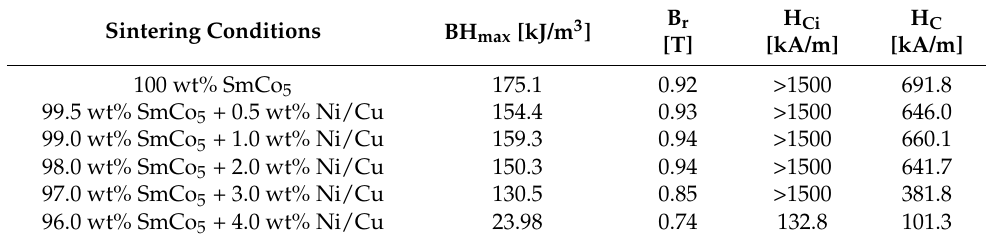
Table 2. Magnetic properties for the magnets with 0–4 wt%